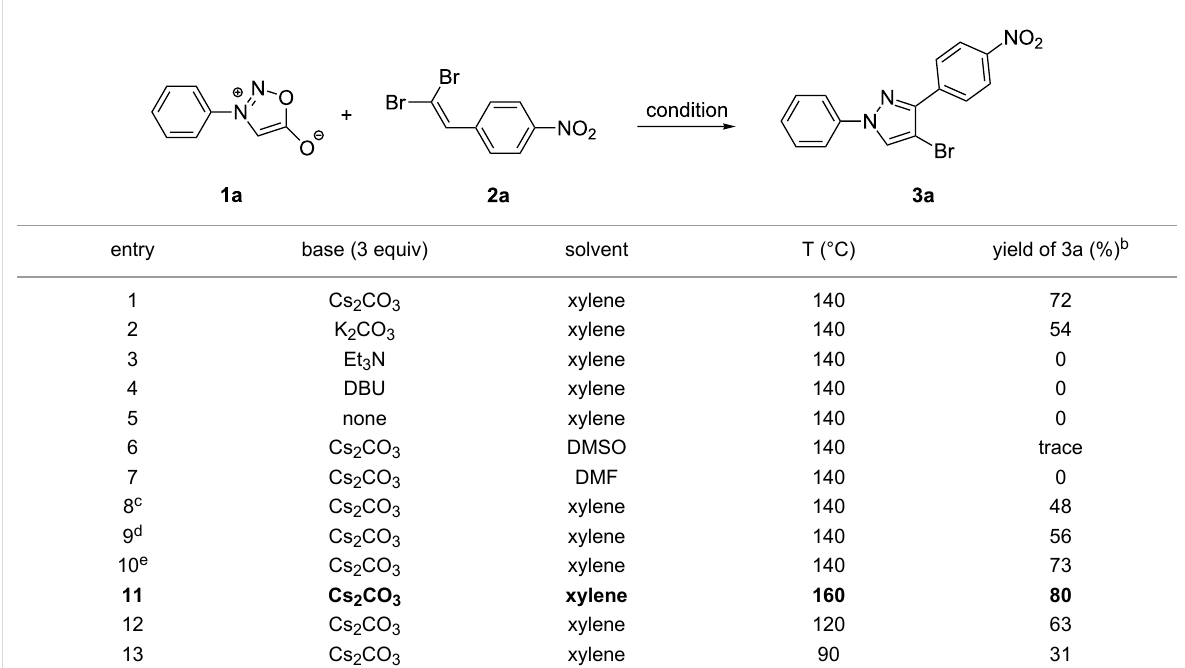
Table 1: Screening for optimal reaction conditions. a